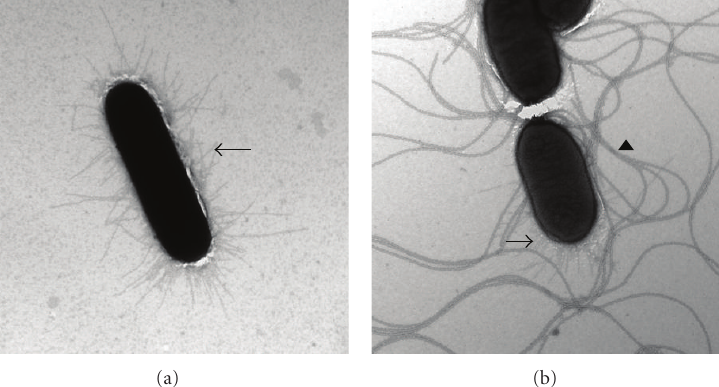
Figure 1: Observation of Salmonella enterica subsp. enterica serovar Typhimurium LB5010 and the stbC mutant strain grown in static broth culture. (a) Salmonella enterica subsp. enterica serovar Typhimurium LB5010 strain grown in static LB broth condition at 37 ◦ C for 48 h produced fimbrial appendages (arrow). No flagella structures were observed. (b) Salmonella enterica subsp. enterica serovar Typhimurium stbC mutant strain grown in static LB broth condition at 37 ◦ C for 48 h produced fimbrial appendages (arrow) and flagella structures (arrowhead). Bacterial cells were negatively stained with 2% of phosphotungstic acid (20,000x).